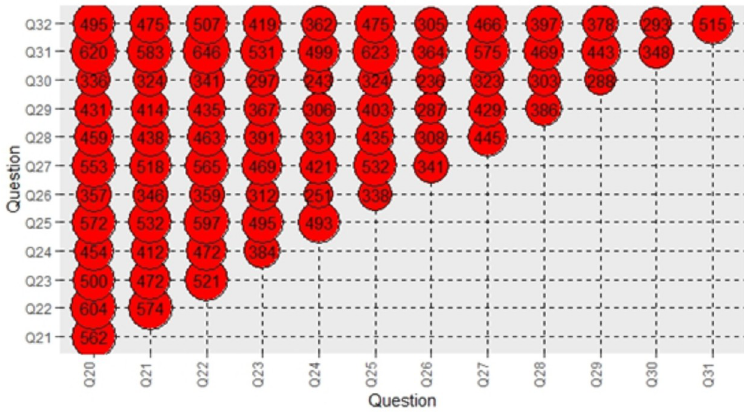
Fig 1. Combinations of the correct answers to the questions about vaccination’s knowledge.